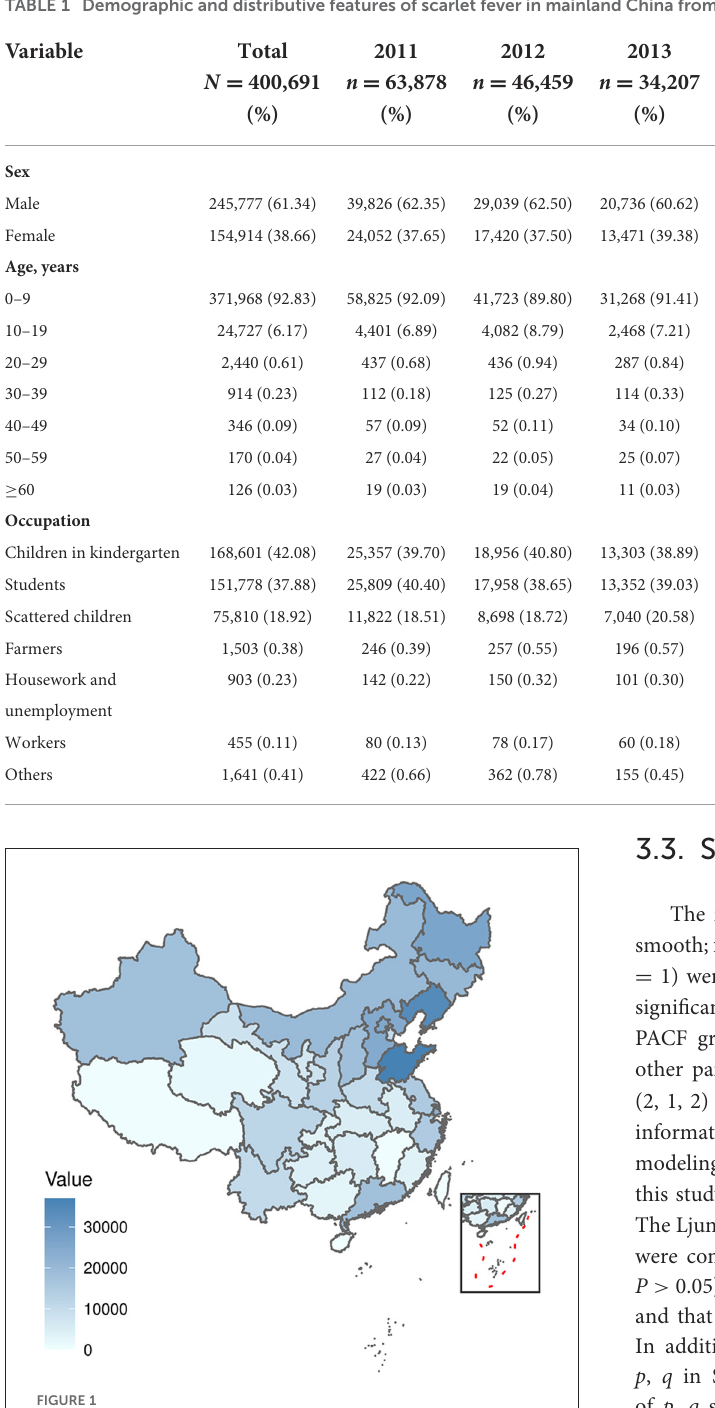
FIGURE1 Distribution of the total number of scarlet fever cases in each province in China from 2011 to